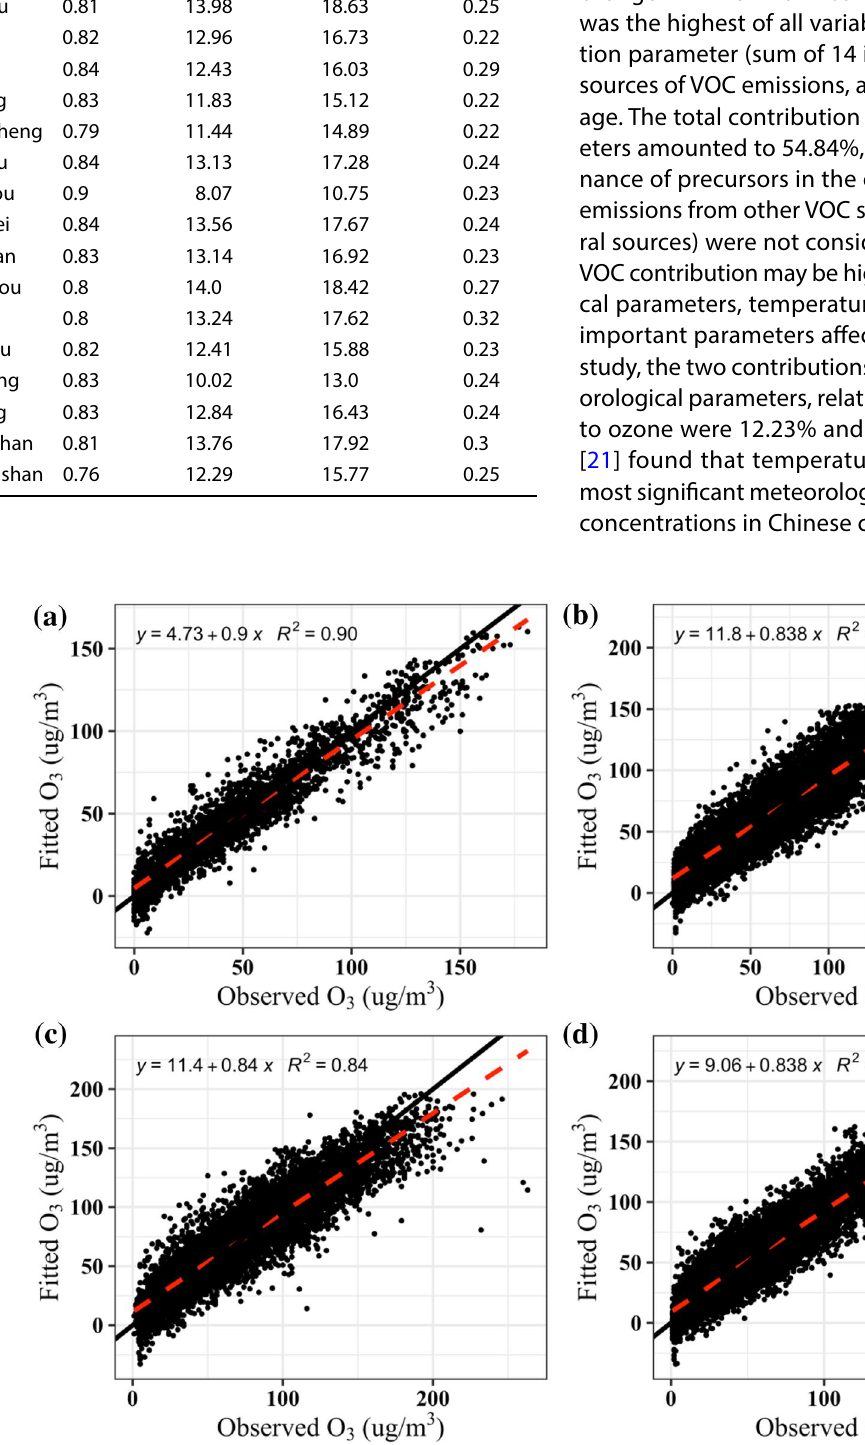
Fig. 3 Relationships between the observed and the fitted ozone concentrations in Chizhou ( a ), Huaibei ( b ), Suzhou ( c ) and Hefei ( d